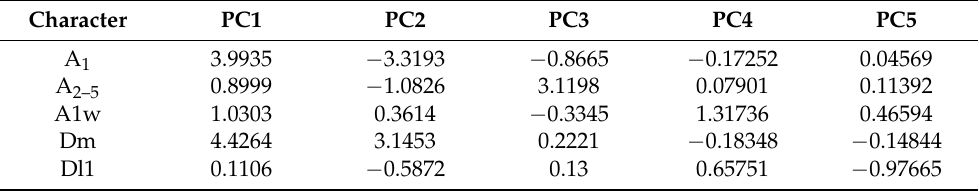
Table 5. Factor loadings of the variables included in